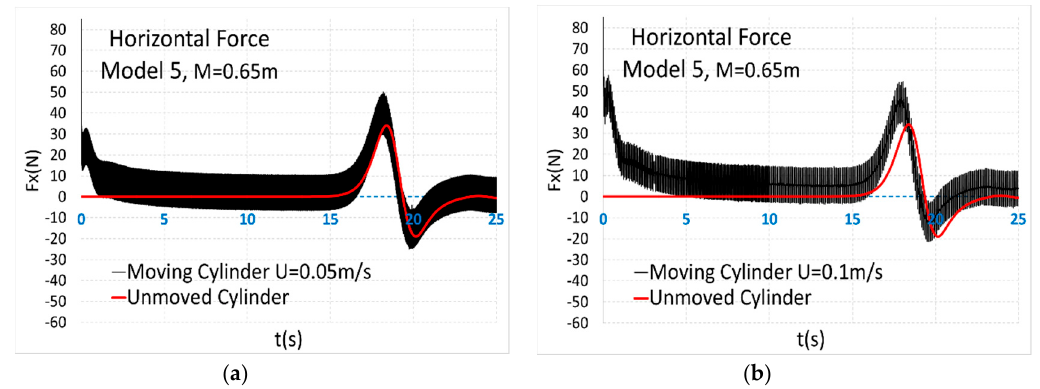
Figure 11. The time variation of the horizontal forces for model 4. ( a ) A comparison between the unmoved cylinder (red line) and the moving cylinder at U c = 0.05 m/s. ( b ) A comparison between the unmoved cylinder (red line) and the moving cylinder at U c = 0.1 m/s.